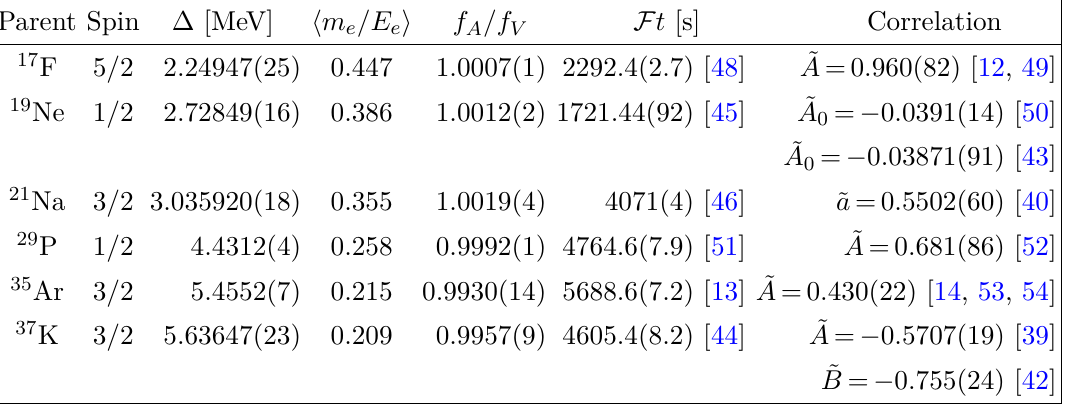
Table 1 . Mirror beta decays used in this analysis. The quantity h m e /E e i is calculated via eq. (2.6), using the endpoint energy listed in the table. The latter are taken from AME2016 [47], except that of 21 Na [46]. The values of f come from refs. [33, 41]. We also used the notation ˜ A A /f V